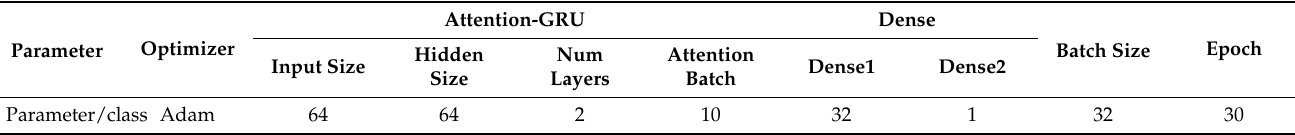
Figure 9. Attention-GRU model for RUL prediction experiments. Table 4. Parameter configuration of the attention-GRU model.